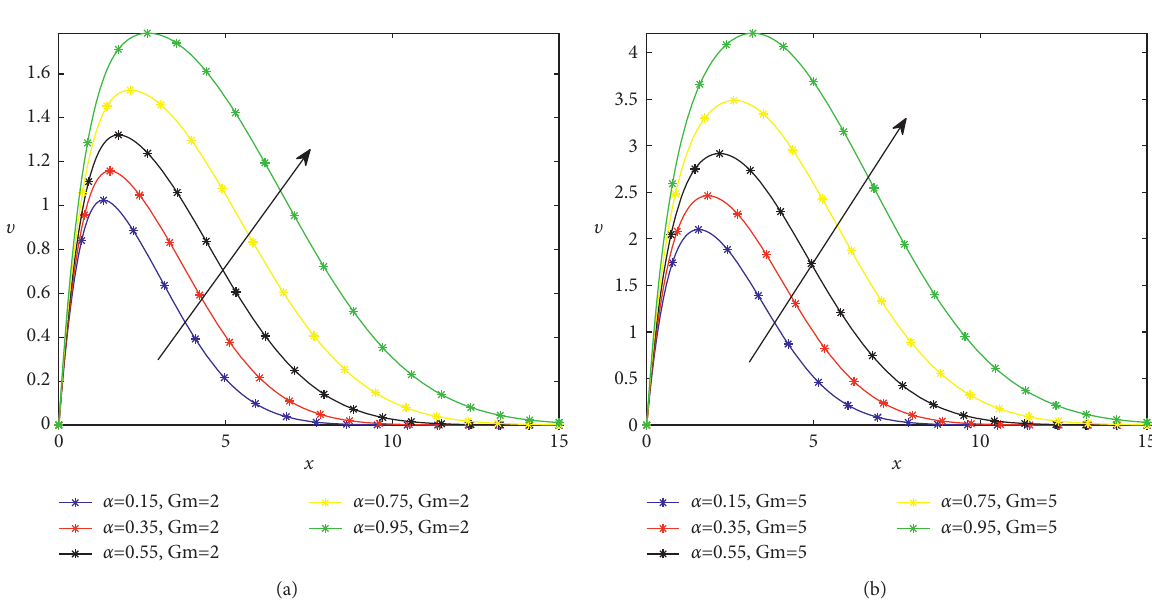
Figure 9: Velocities for different values of order α .